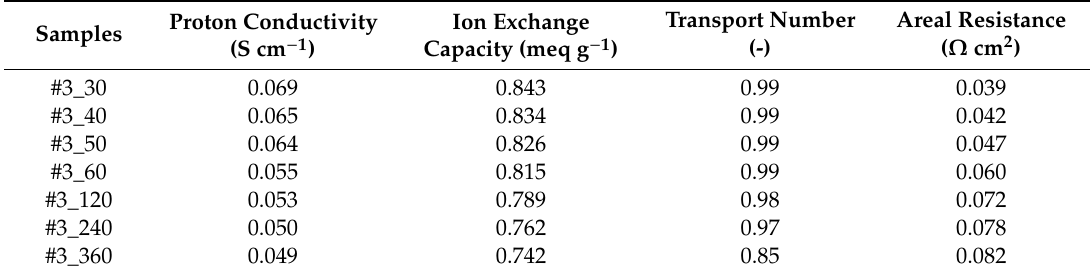
Table 6. Electrochemical properties of composite membranes using Zeus porous substrates with incubation time in the GA / #3